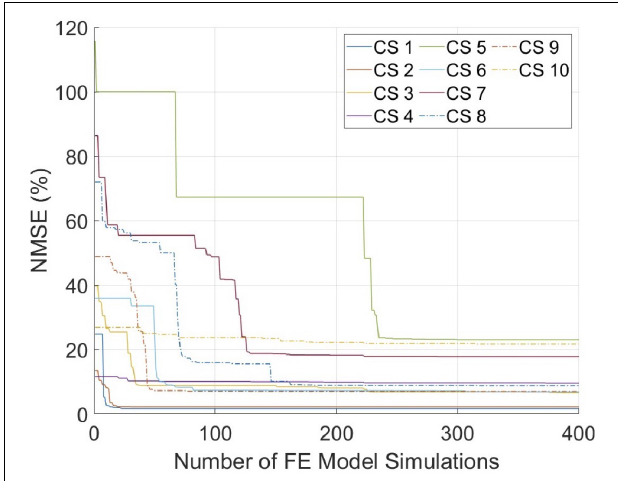
FIGURE 4 | The convergence graphs of the inverse finite element modeling (iFEM) evaluations. CS, cross-section; FE, finite element; NMSE, normalized mean square